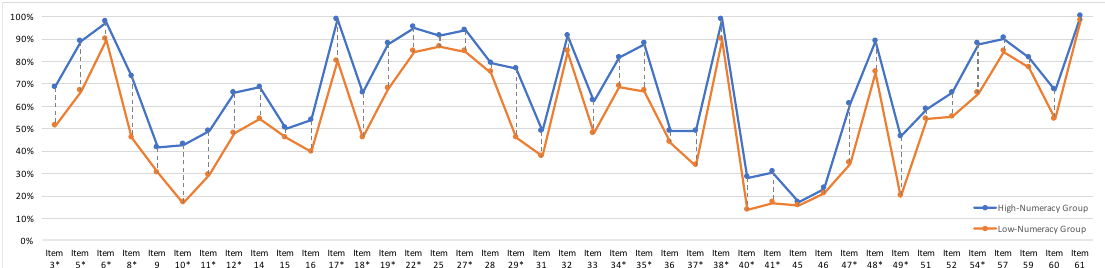
Figure 6. The percentages of high-numeracy group and low-numeracy group who answered Item i correctly. The asterisk marks indicate items that have a significant difference between the two groups based on the two-proportion Z -tests ( ∗ p < 0.05).